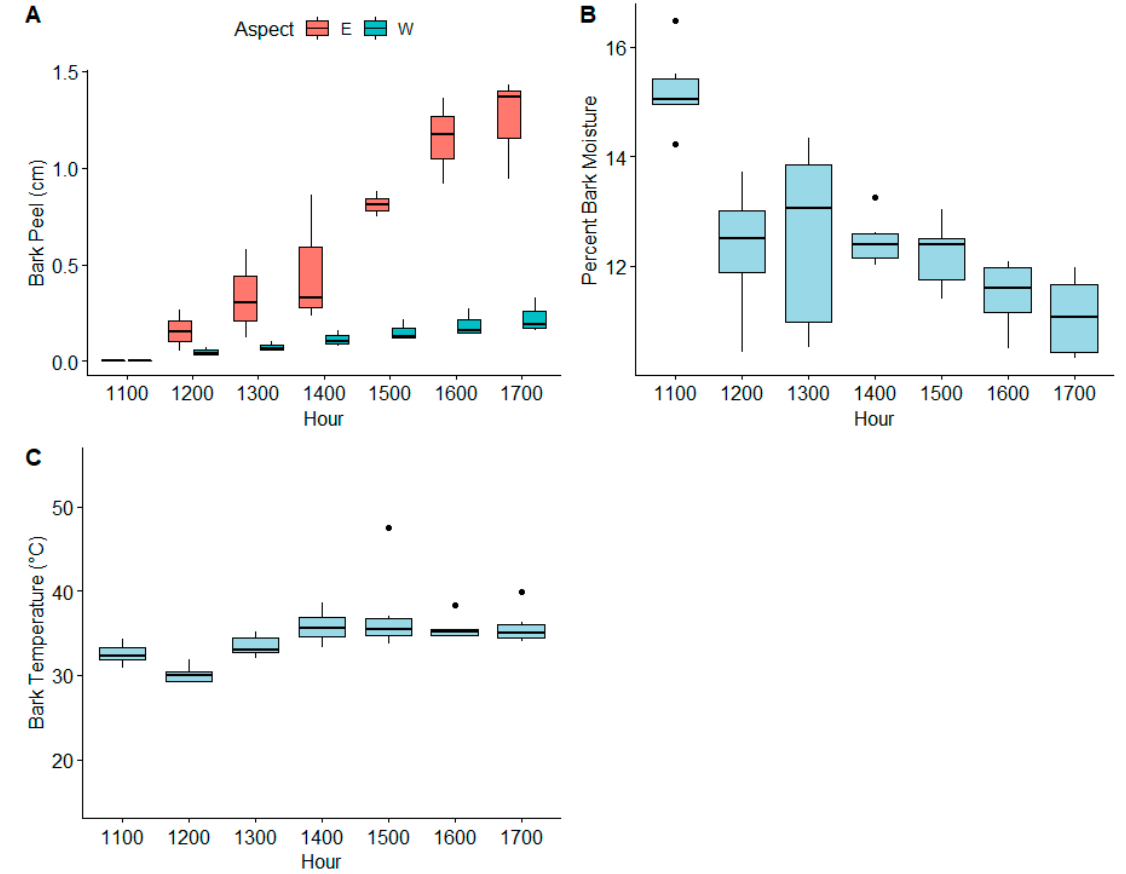
Figure 3. For pitch pine, ( A ) cumulative bark peeling averages (cm) by aspect during the 6-h observation period ( n = 21). ( B ) Mean percent bark flake moisture over the duration of the experiment by hour. ( C ) Mean bark surface temperatures (°C) over the duration of the experiment by hour.